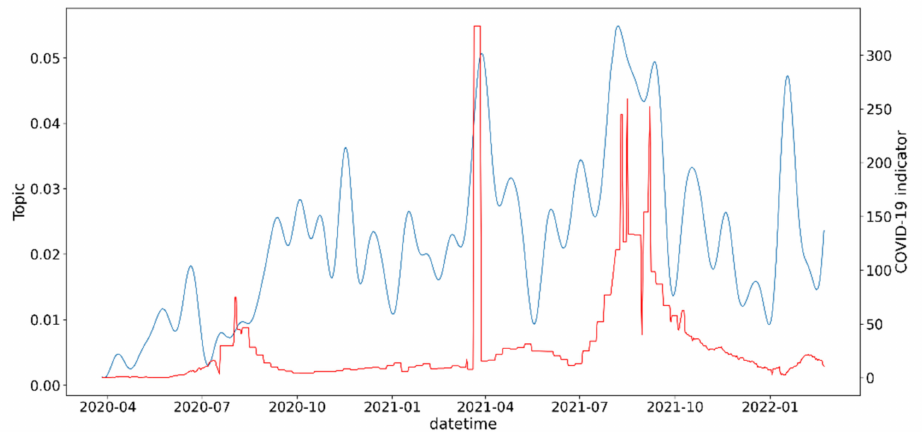
Figure A6. COVID-19 score—New deaths. Topic—Morbidity, School, Child, Growth, Epidemiologi- cal, Among,